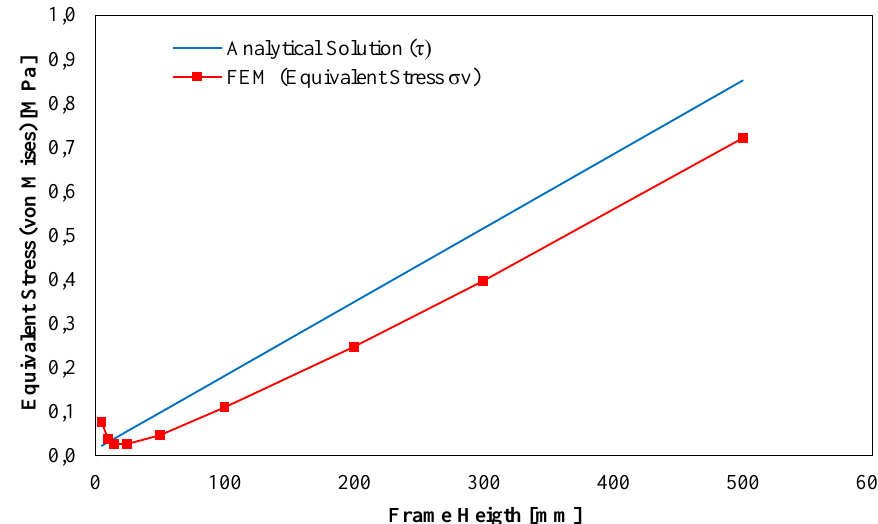
Fig. 14 Influence of the frame height on the resulting stress in the SG joint caused by cold bending for the geometry and forced deformation of the façade elements of Mistral